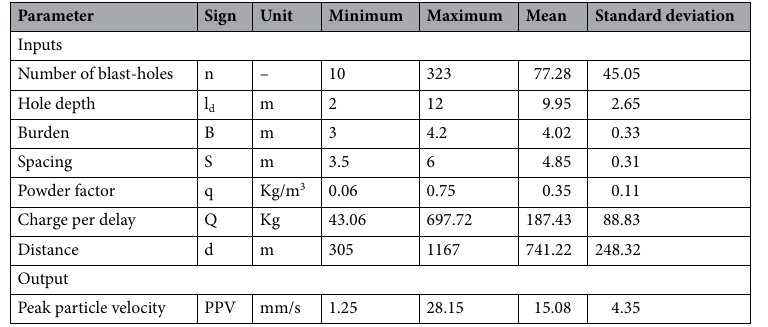
Table 2. The properties of the parameters and their ranges.